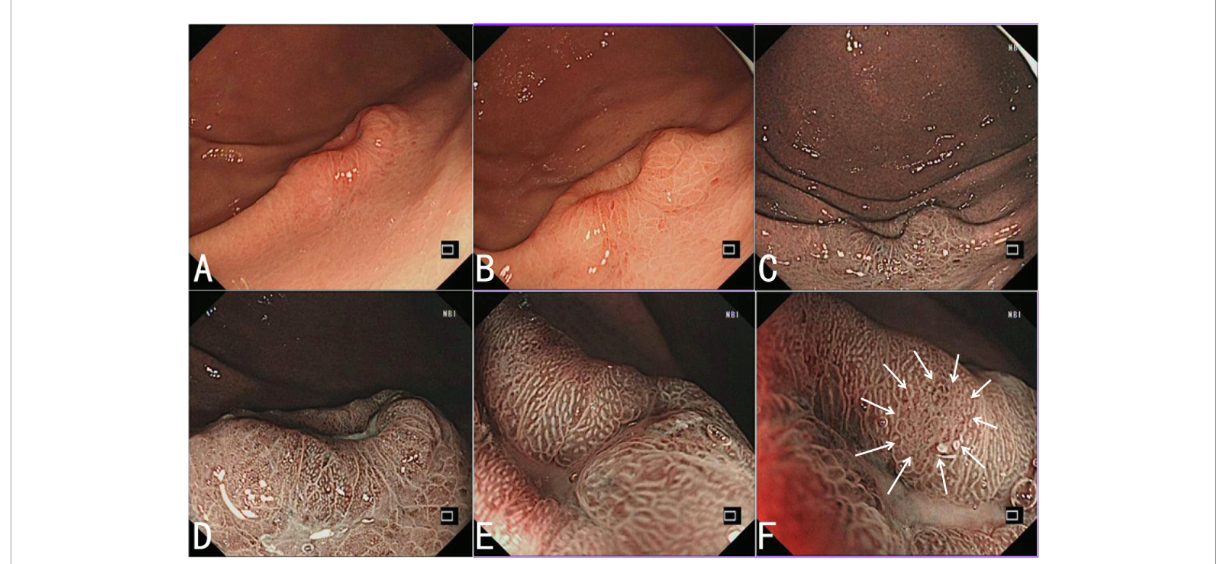
FIGURE 1 Endoscopic features of HAS. (A, B) White light endoscopy shows a 20-mm type 0 – IIa+IIc lesion with submucosal tumor-like change in the greater curvature of the junction between the antrum and body. The lesion has a sense of compactness and fullness with a central depression. (C) NBI shows a brownish area with an indistinct boundary. (D – F) ME-NBI with low (D) and high (E) magni fi cation shows that most parts of the lesion present as a regular microvascular pattern, and there is the presence of a demarcation line, some widened intervening parts, and elongated pits, and only small parts present as an irregular microvascular pattern (indicated by the arrow) (F)